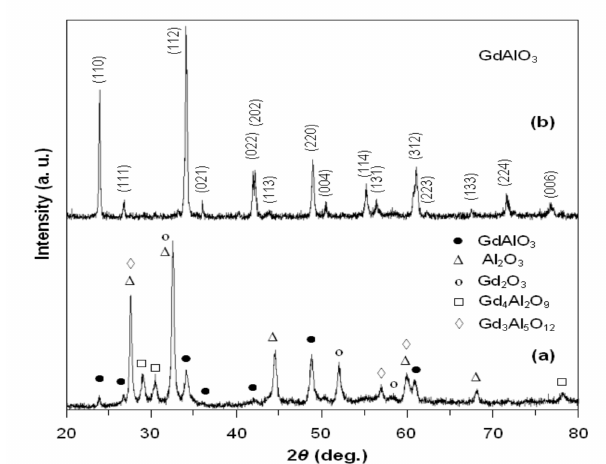
Figure 2. The X-ray diffractograms for gadolinium aluminate heat treated at 900 ◦ C/1 h ( a ) and 1000 ◦ C/7 h ( b ).